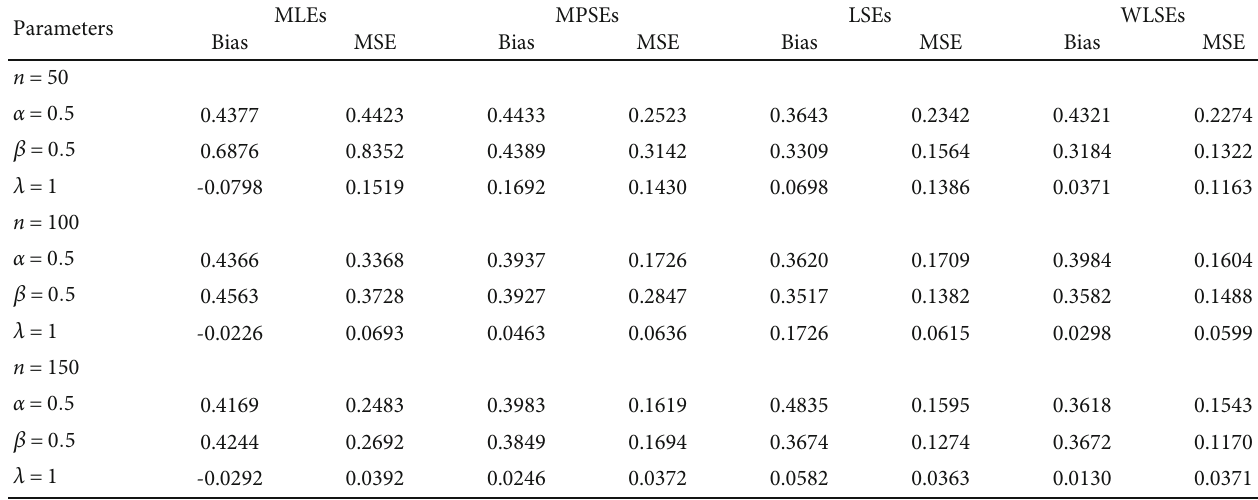
Table 1: Bias and MSE values for α , β , and λ of the XGAIW distribution.